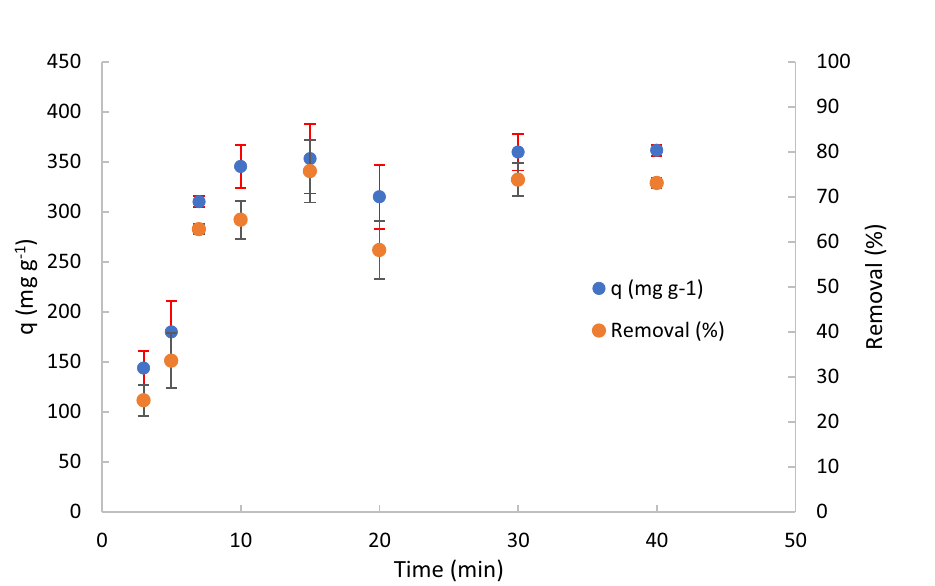
Figure 7. Adsorption capacity and removal for different Initial concentration of DCF. C 0 = 10, 20, 40, 100, 200 and 250 mg L −1 , pH 1, 10 mg of adsorbent material, stirring speed = 650 rpm, contact time = 10 min.